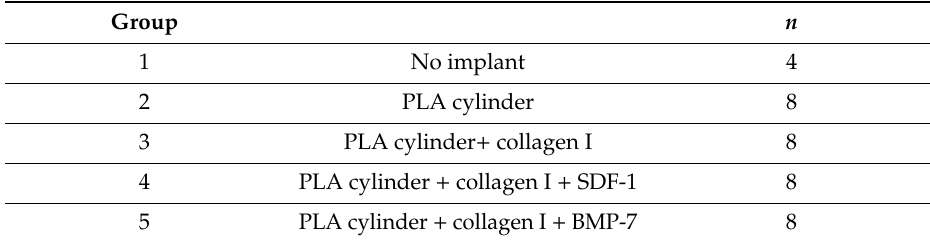
Table 1. Classification of